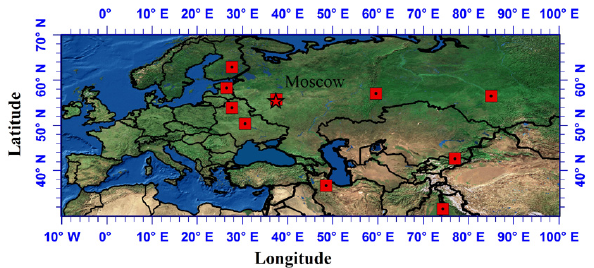
Table 2. EPA air quality index levels and breakpoints for PM 2 . 5